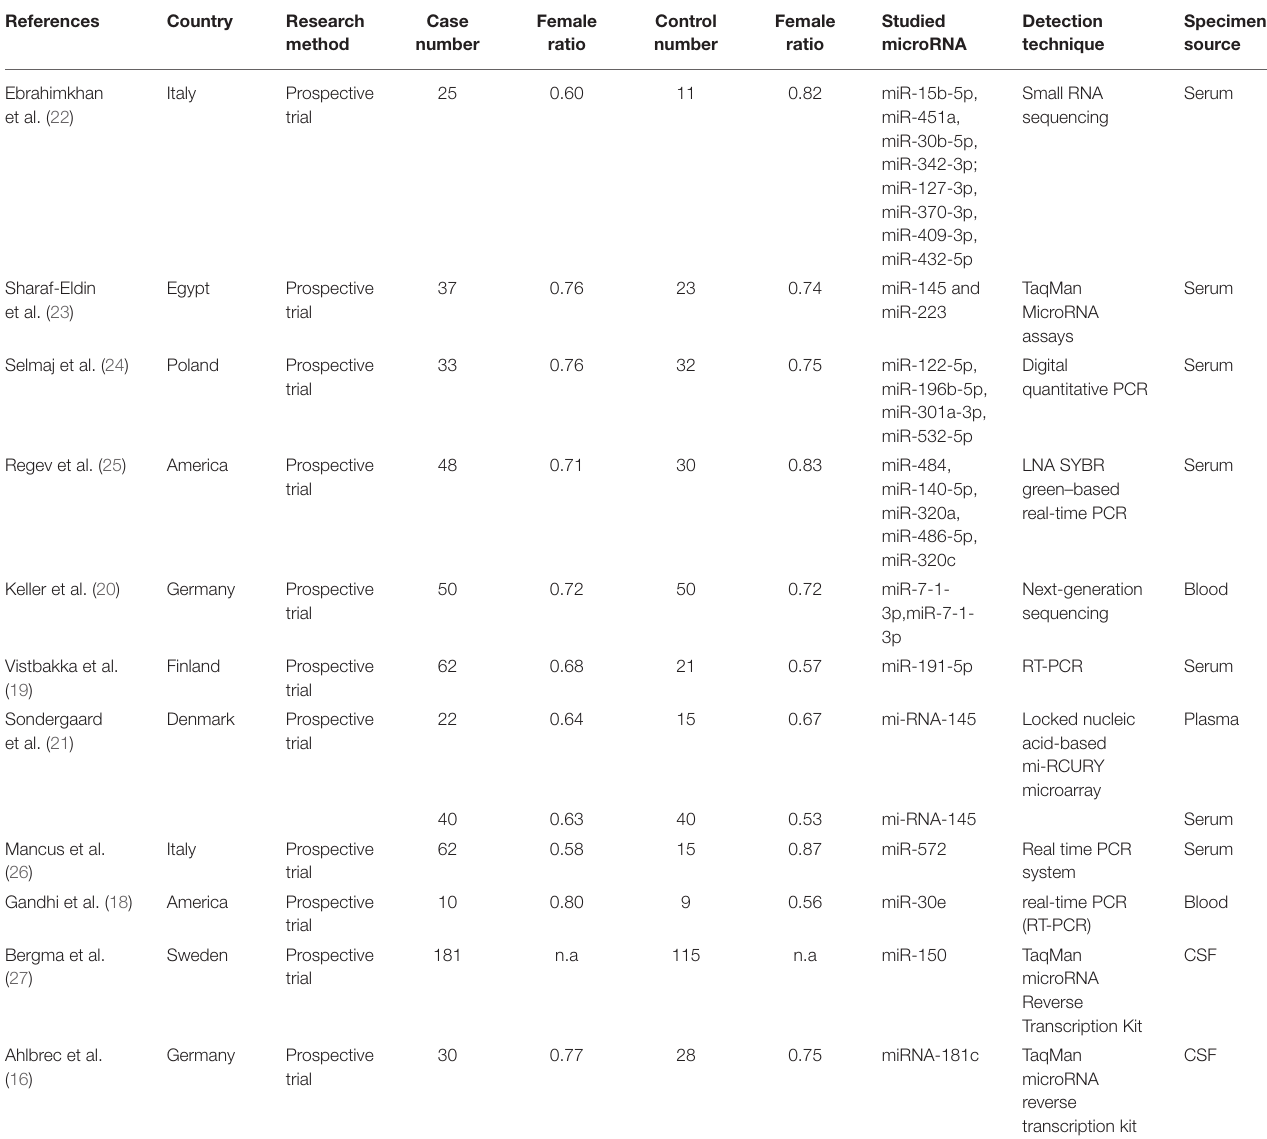
TABLE 1 | Basic information of included